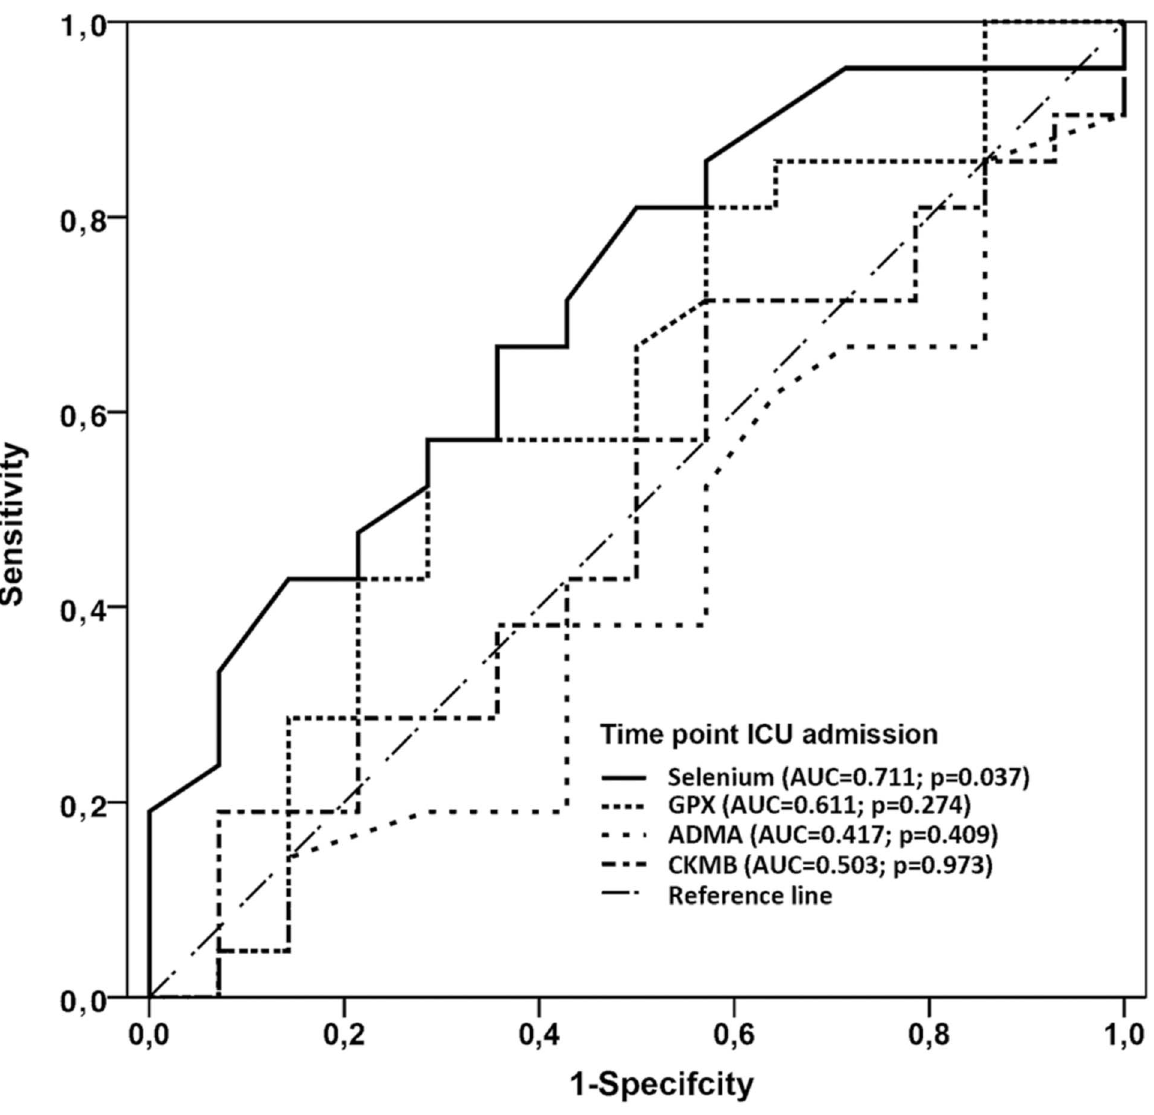
Figure 5. Receiver operating characteristic curve (all patients). Receiver operating characteristic curve for the significance of postoperative (admission to ICU) selenium, GPx, ADMA and CK-MB concentrations in all patients to predict the development of organ dysfunction in the postoperative period. AUC, area under the receiver operating curve.